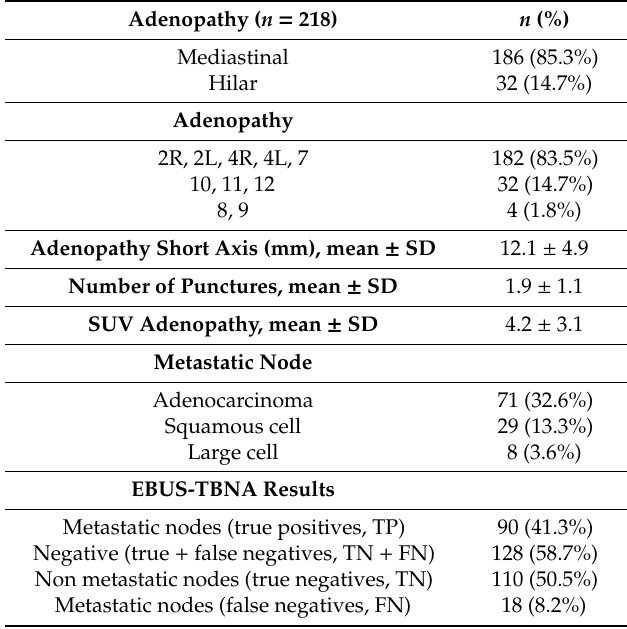
Table 1. Characteristics of lymph nodes.